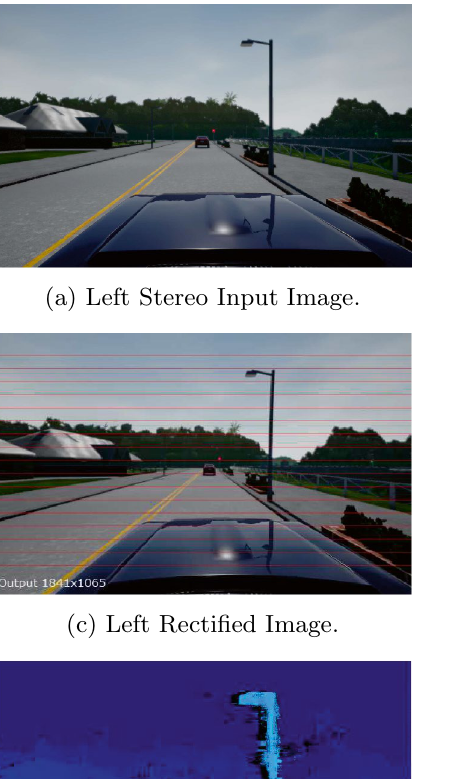
(e) Stereo Disparity Map. (f) Object Detection.